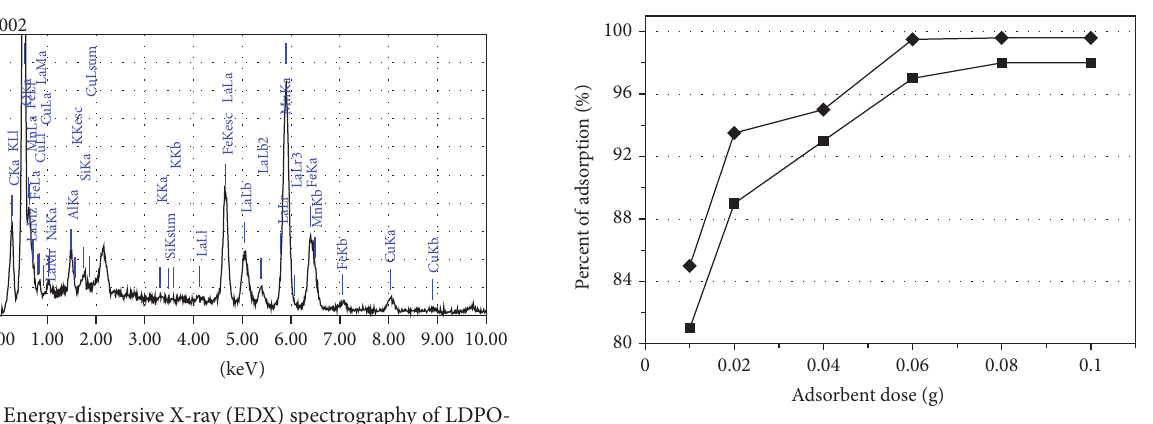
Figure 2: Energy-dispersive X-ray (EDX) spectrography of LDPO- G.